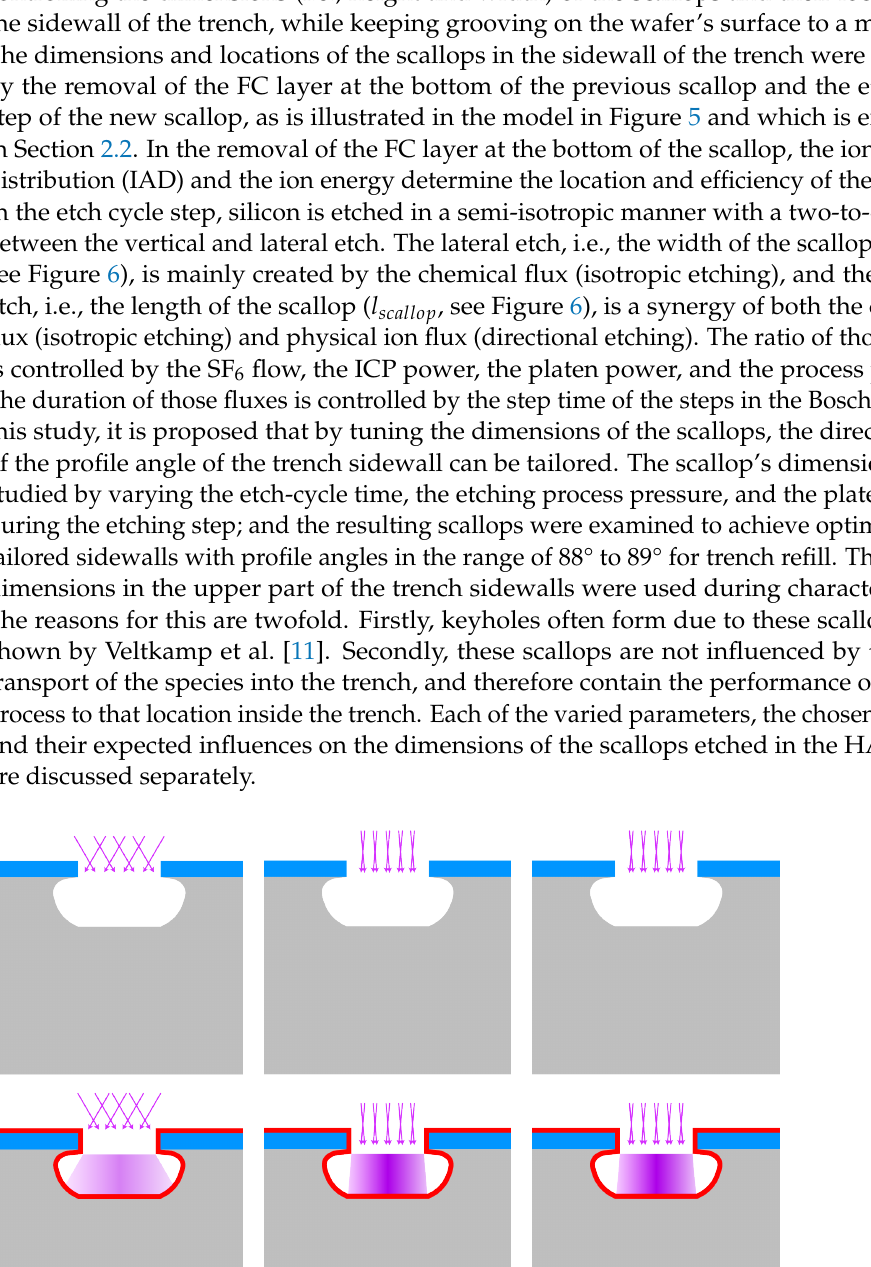
( c ) Figure 5. HAR profile control by scallop dimension and position tailoring by utilising the etch-cycle time and pressure (IAD). In ( a ), a negative trench profile is created by using a large IAD (etch pressure > 30mTorr) and constant etch-cycle time. In ( b ), a directional trench profile is created by using a small IAD (etch pressure < 10mTorr) and constant etch-cycle time [28,29]. In ( c ), a positive trench profile is created by using relatively short and constant (or ramped down) etch-cycle time and a small IAD. In this image, the colours correspond to the following materials: silicon, t-SiO 2 hard mask, and FC passivation layer. The purple colour in the second row indicates the IAD in the plasma. The concentration of ions is the highest in the centre (near perpendicular to the surface).